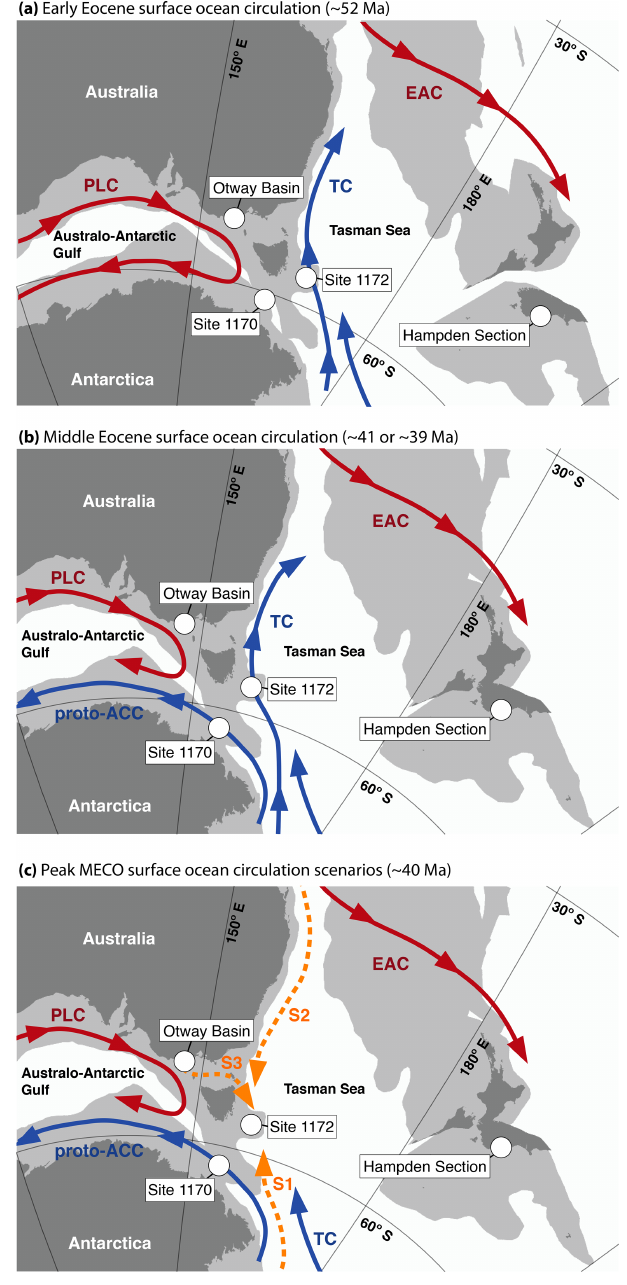
Figure 1. Inferred generalized Eocene surface-ocean circulation patterns in the southwest Pacific Ocean based on dinocyst biogeographic patterns. (a) Generalized early Eocene ( ∼ 52Ma) surface-ocean circulation. (b) Generalized middle Eocene surface-ocean circulation pre- MECO ( ∼ 41Ma) and post-MECO ( ∼ 39Ma). (c) Three potential surface-ocean circulation scenarios (S1, S2, and S3) for peak MECO ( ∼ 40Ma) based on dinocyst assemblage constraints (cf. Sect. 5.1). Maps constructed with GPlates, using Torsvik et al. (2012) paleomagnetic rotation frame and Matthews et al. (2016) continental polygons, and coastlines for 52Ma (a) and 40Ma ( b and c ). Note that, within this rotation frame, there is uncertainty in the drawn paleolatitudes. For example, Site 1170 is drawn at 61.6 ◦ S at 40Ma, but the uncertainty margins on this are between 58.76 and 64.55 ◦ S (van Hinsbergen et al., 2015). Currents drawn after reconstructions by Bijl et al. (2011, 2013a, b) and this study. EAC represents East Australian Current; PLC represents Proto-Leeuwin Current; TC represents Tasman Current; and proto-ACC represents proto-Antarctic Counter